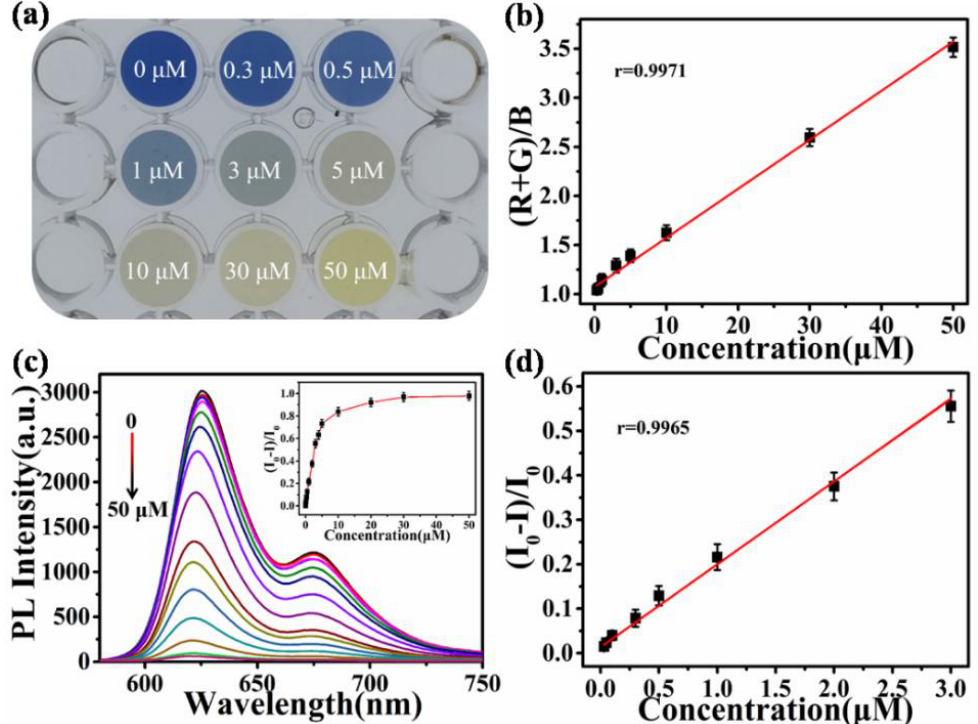
Figure 4. Optical image of R-CDs solution in real 96-well plate with different concentration of Cr(VI) ( a ), linear relationship between (R+G)/B values and Cr(VI) concentrations ( b ). PL spectra of R-CDs solutions with different concentrations Cr(VI) added ( c ), linear relationship between (I 0 − I)/I 0 values and Cr(VI) concentrations ( d ).